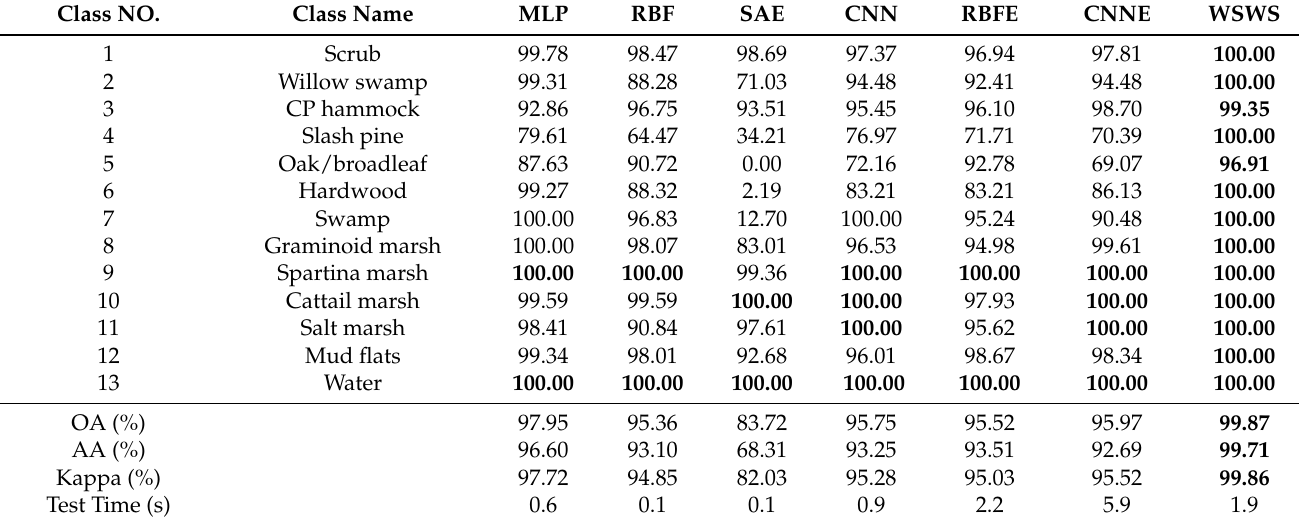
Table 4. Classification results of different methods for